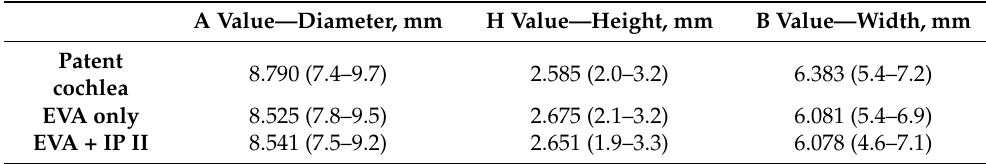
Table 1. Comparison of the mean A, H, and B values between the groups with patent cochleae, EVA only, and EVA + IP II. A Value—Diameter, mm H Value—Height, mm B Value—Width,